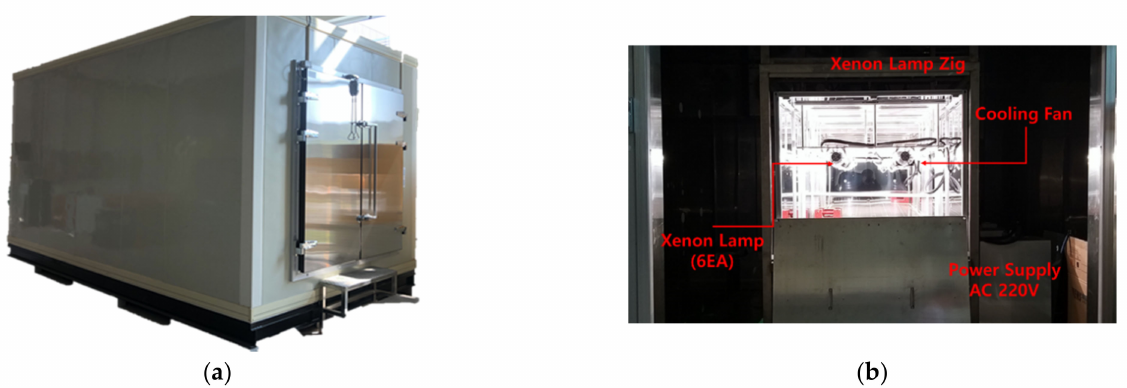
Figure 1. Photographs of the ( a ) exterior and ( b ) the interior of the PV panel experimental